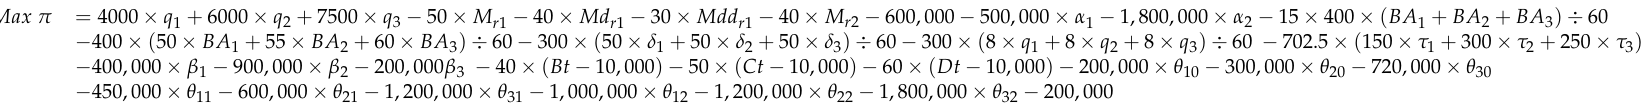
Table A4. The quality management decision model for capacity expansion with carbon tax (Scenario